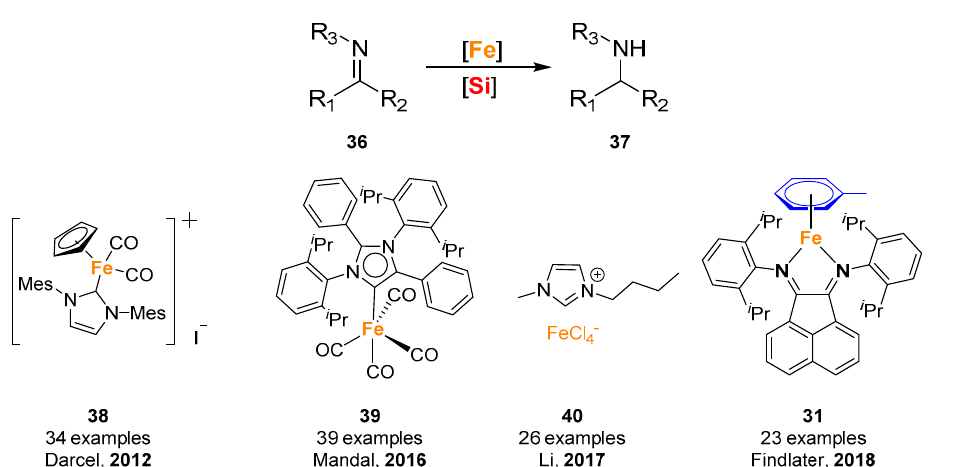
Scheme 6. Understanding the concept of redox non-innocence [127,128].